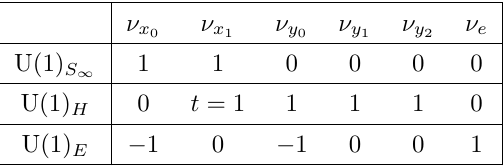
Table 2 . GLSM charges of the toric coordinates of the internal manifold B 3 , obtained by blowing up the P 1 -(cid:12)bered three-fold H t =1 along a hyperplane curve in its P 2